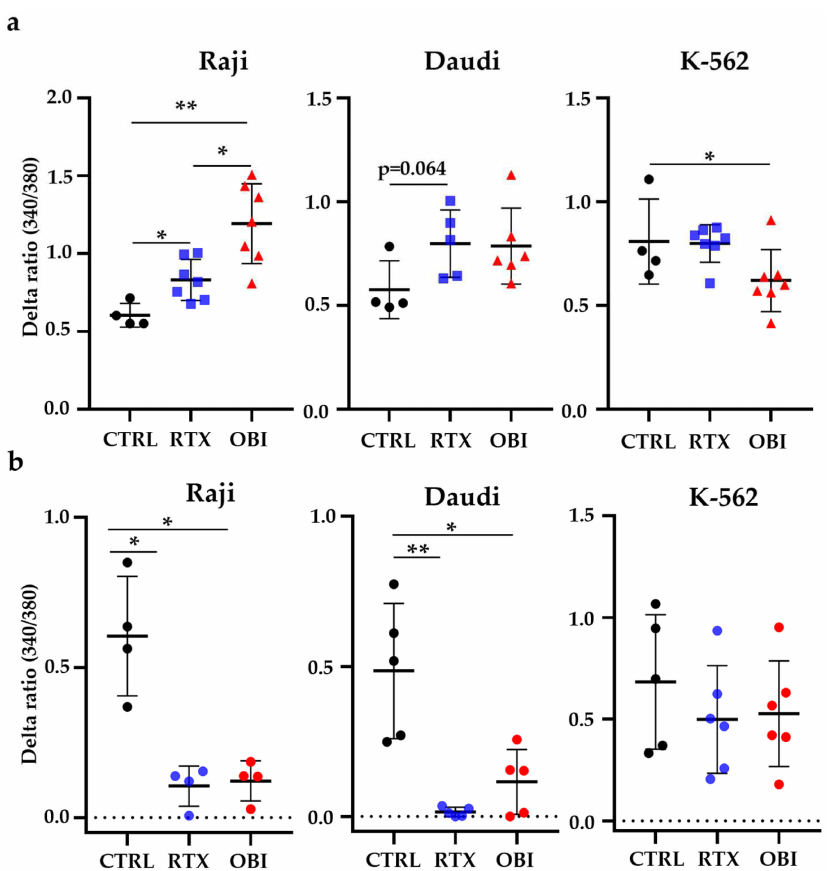
Figure 8. CD20 mAbs show antagonist effects on CCE depending on treatment duration. ( a ) Cells were treated with 10 µ g/mL of RTX or OBI for 45 min and CCE was measured after addition of 5 mM of calcium. ( b ) RTX or OBI was applied just before adding 5 mM of extracellular calcium. Intracellular Ca2+ variations compared to the control condition were evaluated using the fluorescence emission of the Fura2 probe measured at 510 nm with an excitation light at 340 and 380 nm. Each graphic represents mean +/ − SD of the number of experiments depicted in the graphs. Mann–Whitney was used to compare treatments. * p < 0.05; ** p <